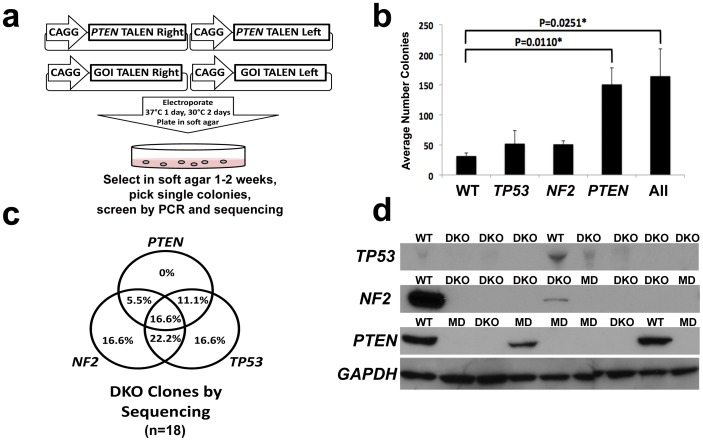
Co-targeting PTEN allows for robust enrichment and isolation of immortalized human Schwann cells.(a) Diagram of co-targeting PTEN method. (b) Number of colonies formed in soft agar following targeting with PTEN, TP53, or NF2 TALENs alone or in combination compared to untransfected immortalized human Schwann cells (student t-test). (c) Percent DKO clones based on sequence analysis of soft agar selected clones transfected with all three TALEN pairs (n = 18). 11.4% of these clones were either classified as WT or MD at all three target genes. (d) Western blot analysis of a subset of clones analyzed by sequencing.